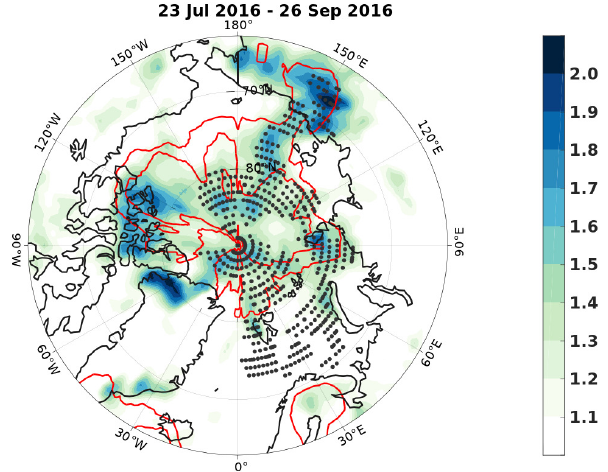
Figure 10. Ratio of accumulated precipitation during the period 23 July to 26 September 2016 with respect to climatological val- ues for the same time period (in color). Red contours show areas with positive anomalies of cyclone occurrences with respect to cli- matology (shown are contours of 5% and 10%). The spatial extent of the patch is represented by the dotted